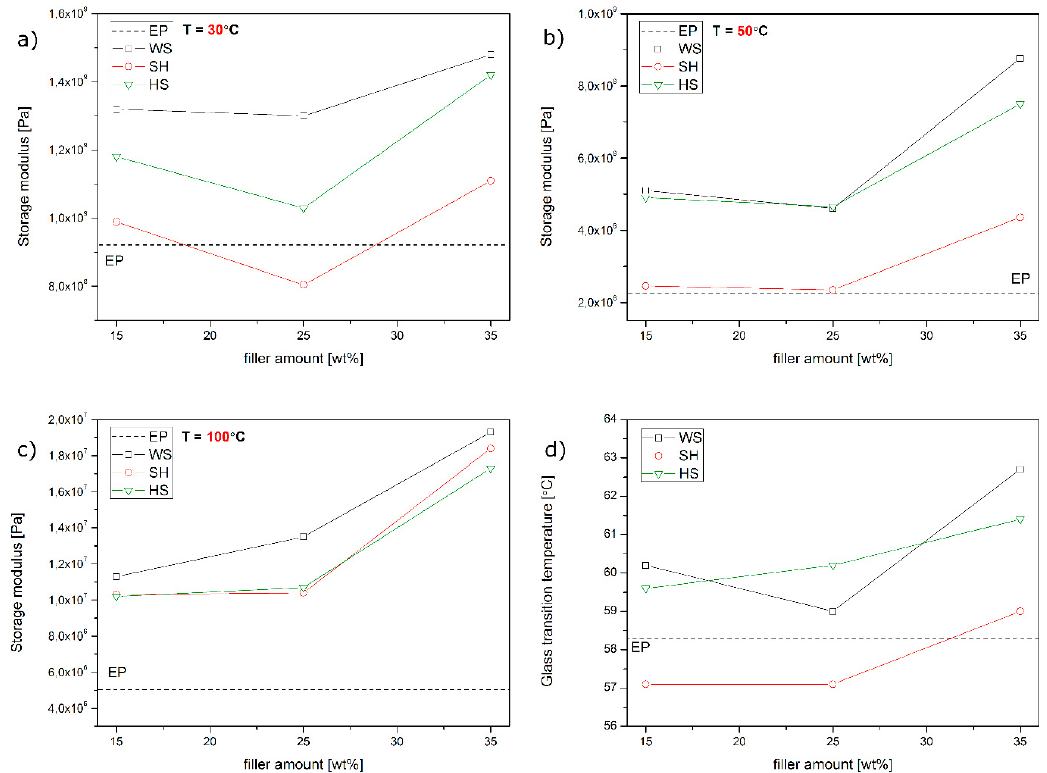
Figure 6. The values of composites storage modulus at various temperatures and glass transition temperature. Table 1. Values determined based on thermogravimetric (TG) analysis conducted for WS, HS, and SH in nitrogen as well as air (organic components).